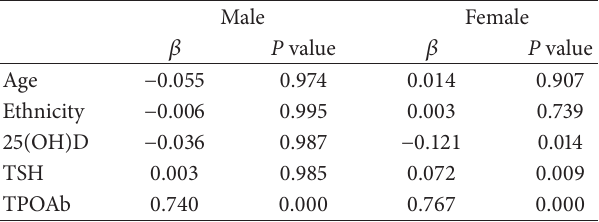
Table 3: Linear regression analysis with serum TgAb as a dependent